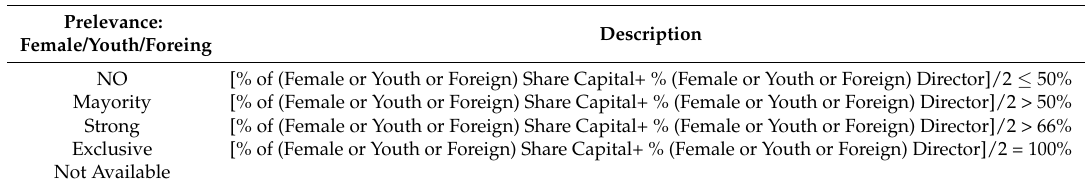
Table A5. Shows the composition of share sapital and of board of directors (or sole director) to consider the orevalence of Italian startups: Majority, Strong, and